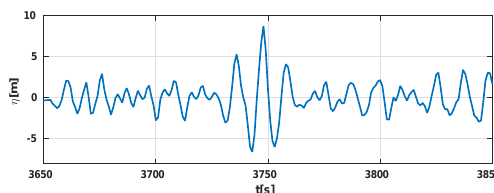
Figure 14. Case W100. Zoomed version of the freak wave; the crest height is 1.35m and the wave height is 2.37 times the significant wave